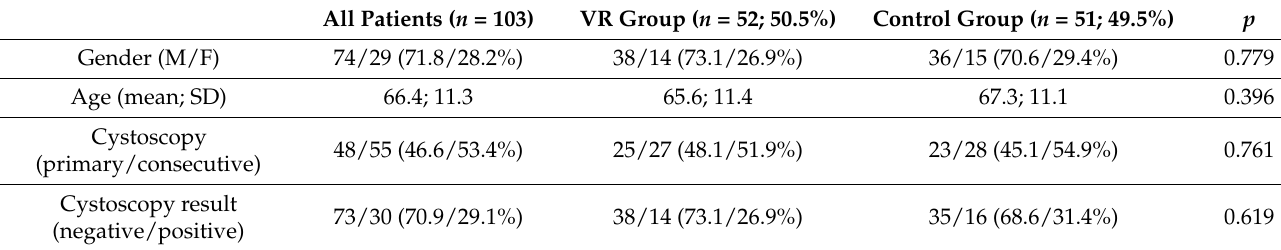
Table 1. Patients’ basic characteristics.